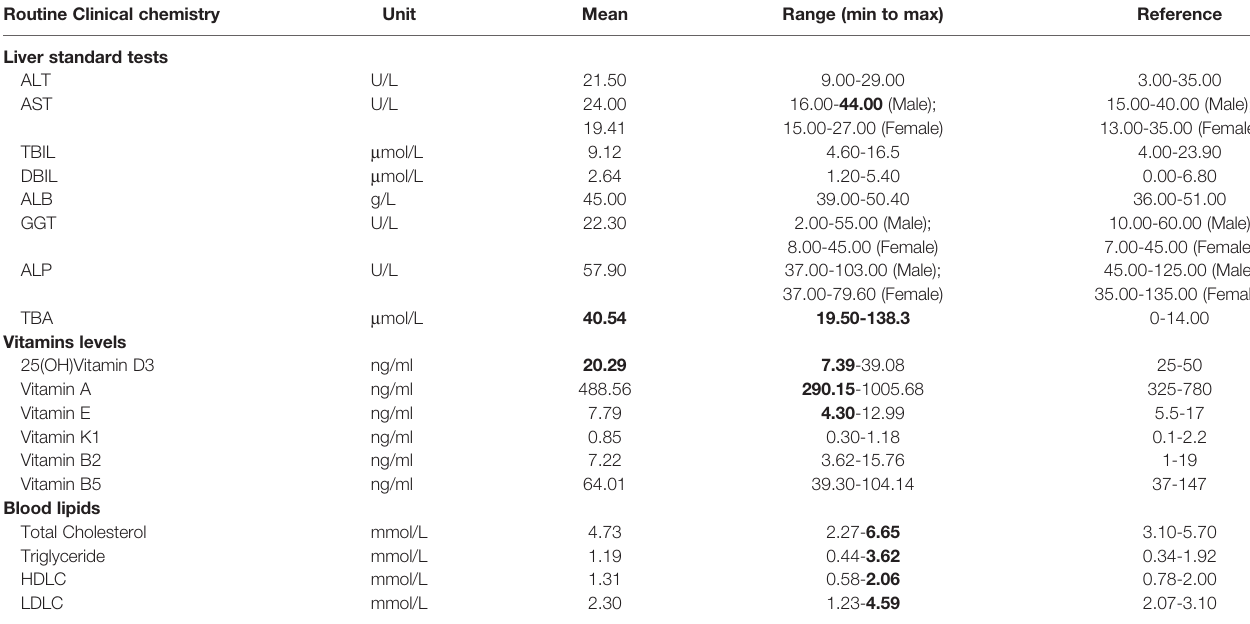
TABLE 1 | Clinical characteristics of 10 homozygous